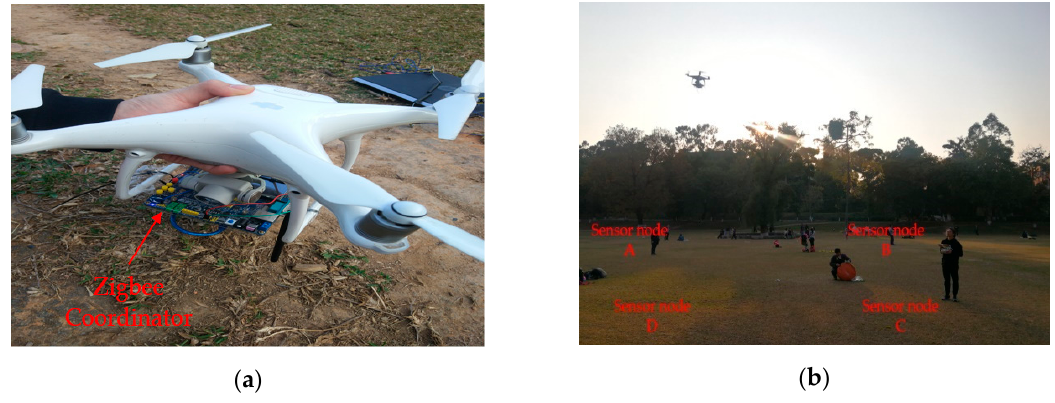
Figure 14. Communication test between UAV and ground WSN nodes. ( a ) UAV with Zigbee Coordinator; ( b ) Ground wireless sensor nodes.